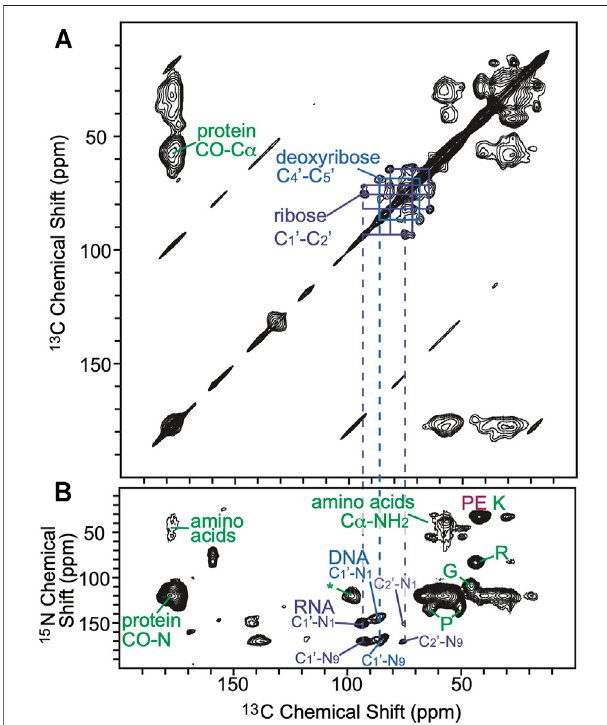
FIGURE 3 | (A) 2D homonuclear correlation spectra (DARR) of cells cryoprotected withDMSO. Selected 13 C – 13 Ccorrelationsfrom carbons inthe ribose (purple) and deoxyribose (blue) rings of RNA and DNA are annotated. (B) 2D heteronuclear correlation spectra (zTEDOR) of cells cryoprotected with DMSO. Selected 13 C- 15 N correlations from the protein back bone and sidechains (green), from RNA (purple), from DNA (blue) and from lipid (pink) are annotated. The signal to noise ratios of selected peaks are reported in Supplementary Table S1